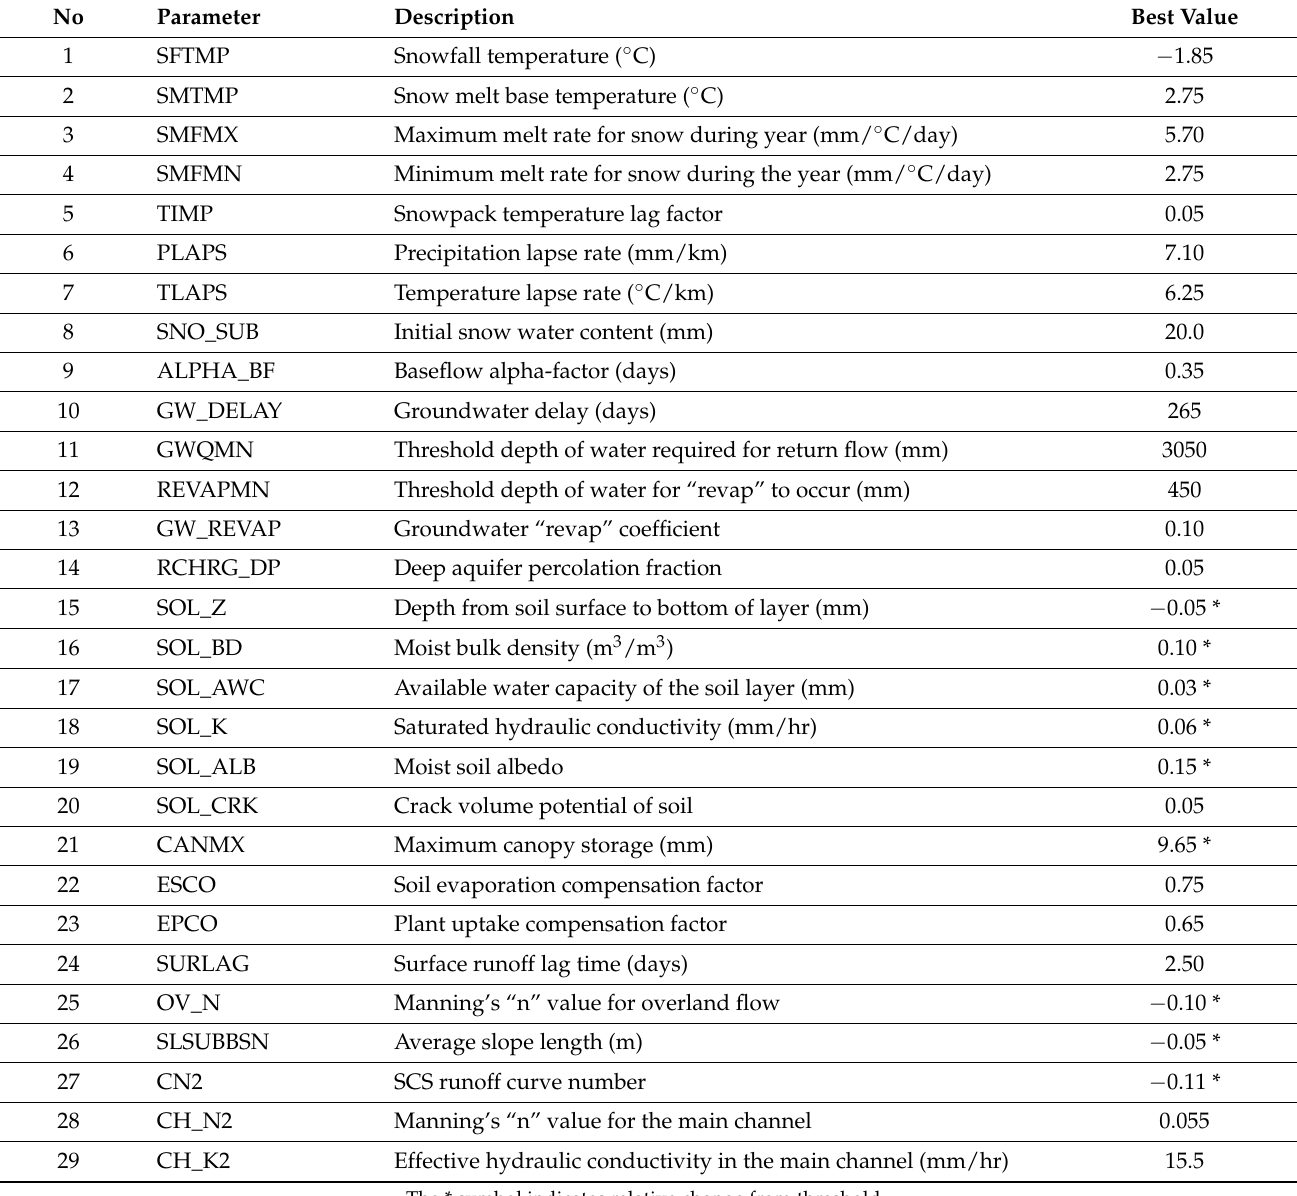
Table 5. Major runoff and flow parameters in the KRB SWAT